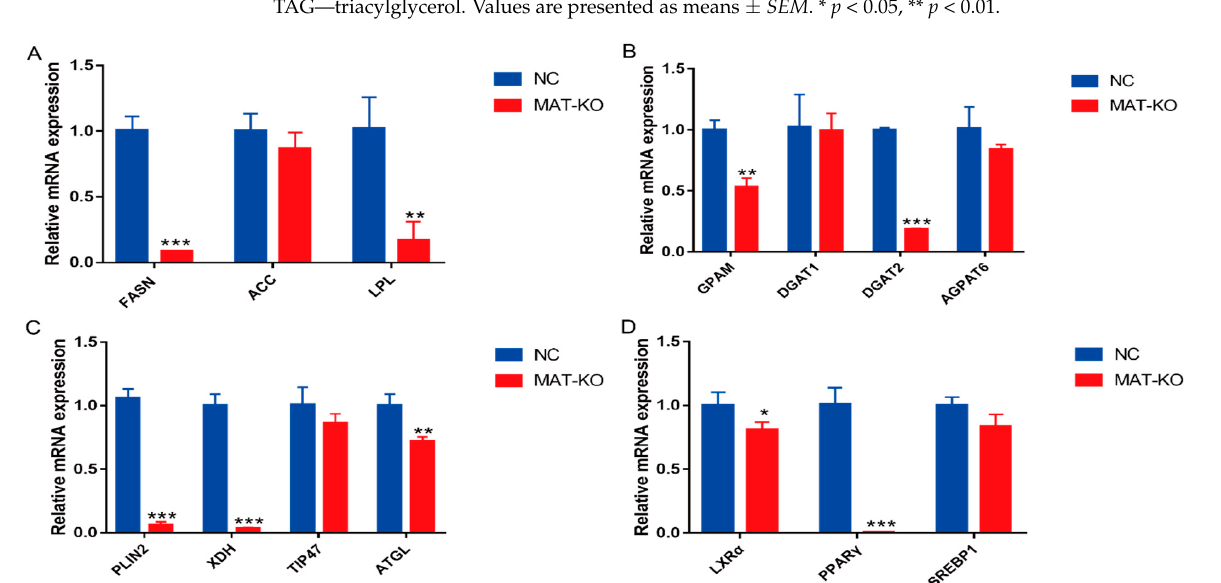
Fatty acid data are shown as ratio of the total fatty acids (%). Statistical analysis was performed with Student’s t test. MCFA—medium-chain fatty acid; PUFA—polyunsaturated fatty acid; UFA—unsaturated fatty acid;